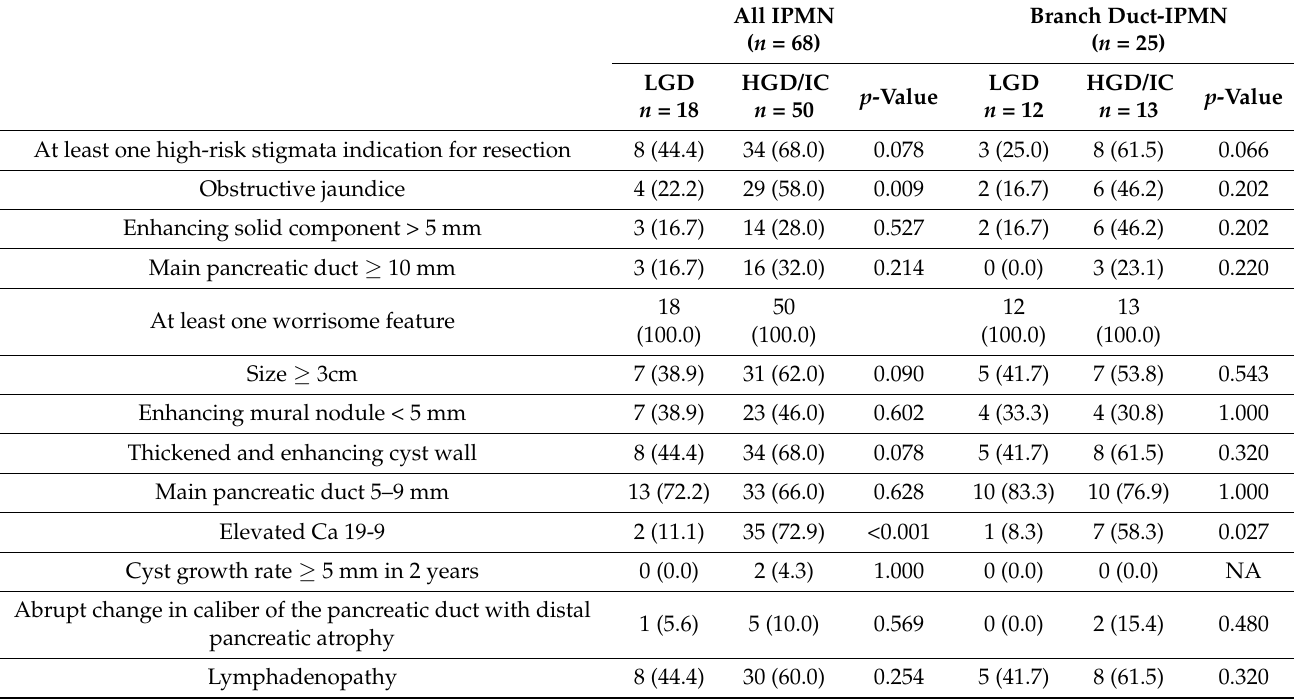
Table 4. Indications for resection according to the Fukuoka consensus guidelines on pancreatic cystic